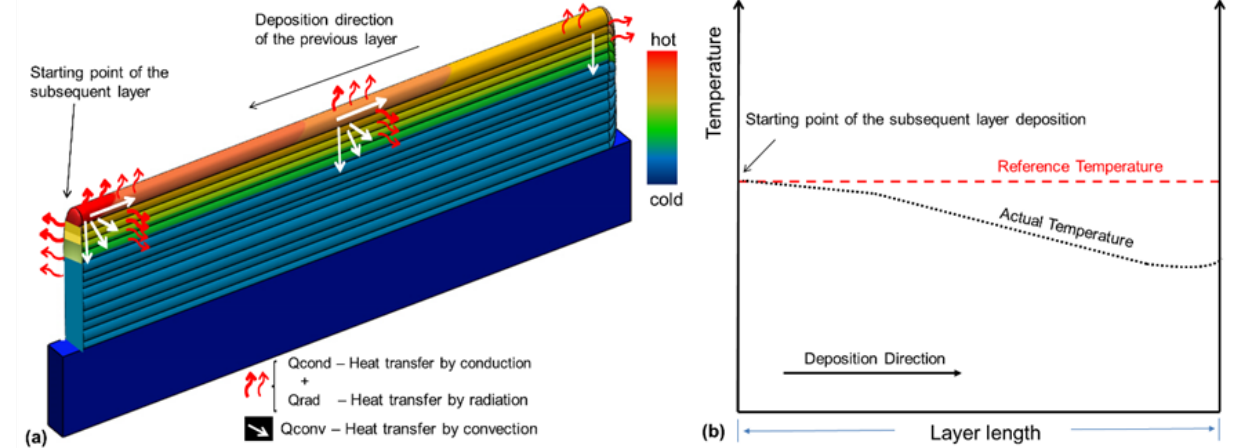
Figure 1. Thin wall constructed by WAAM before starting a new layer deposition: ( a ) qualitative model of the heat exchange mechanisms; ( b ) hypothetical thermal profile.